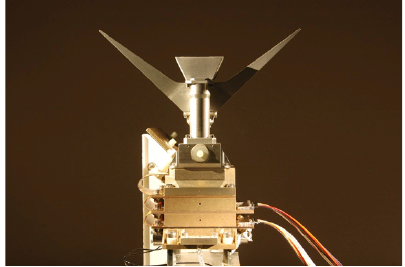
Figure 2. LROC WAC before spacecraft integration